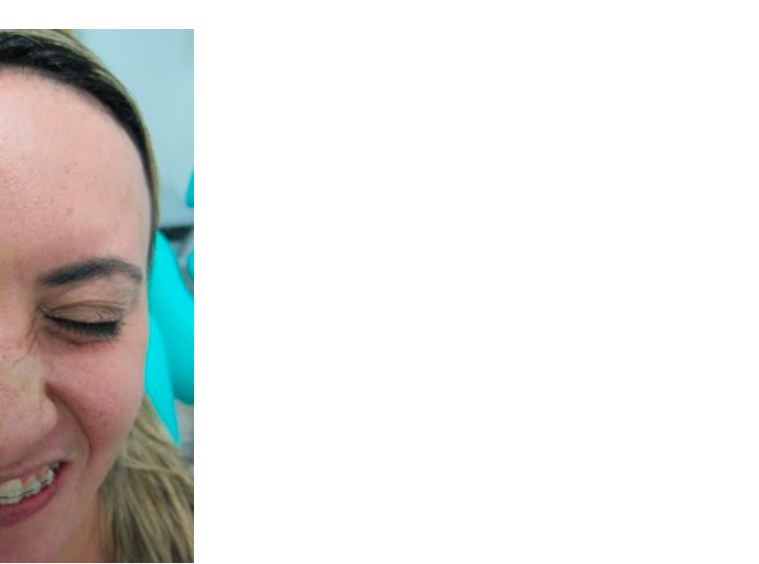
Figure 5. At 2-week follow-up, the patient was noted to have correction of complex facial muscle function and symmetrical appearance of the frontal area with frontal muscle contraction (Figures 6 and 7).